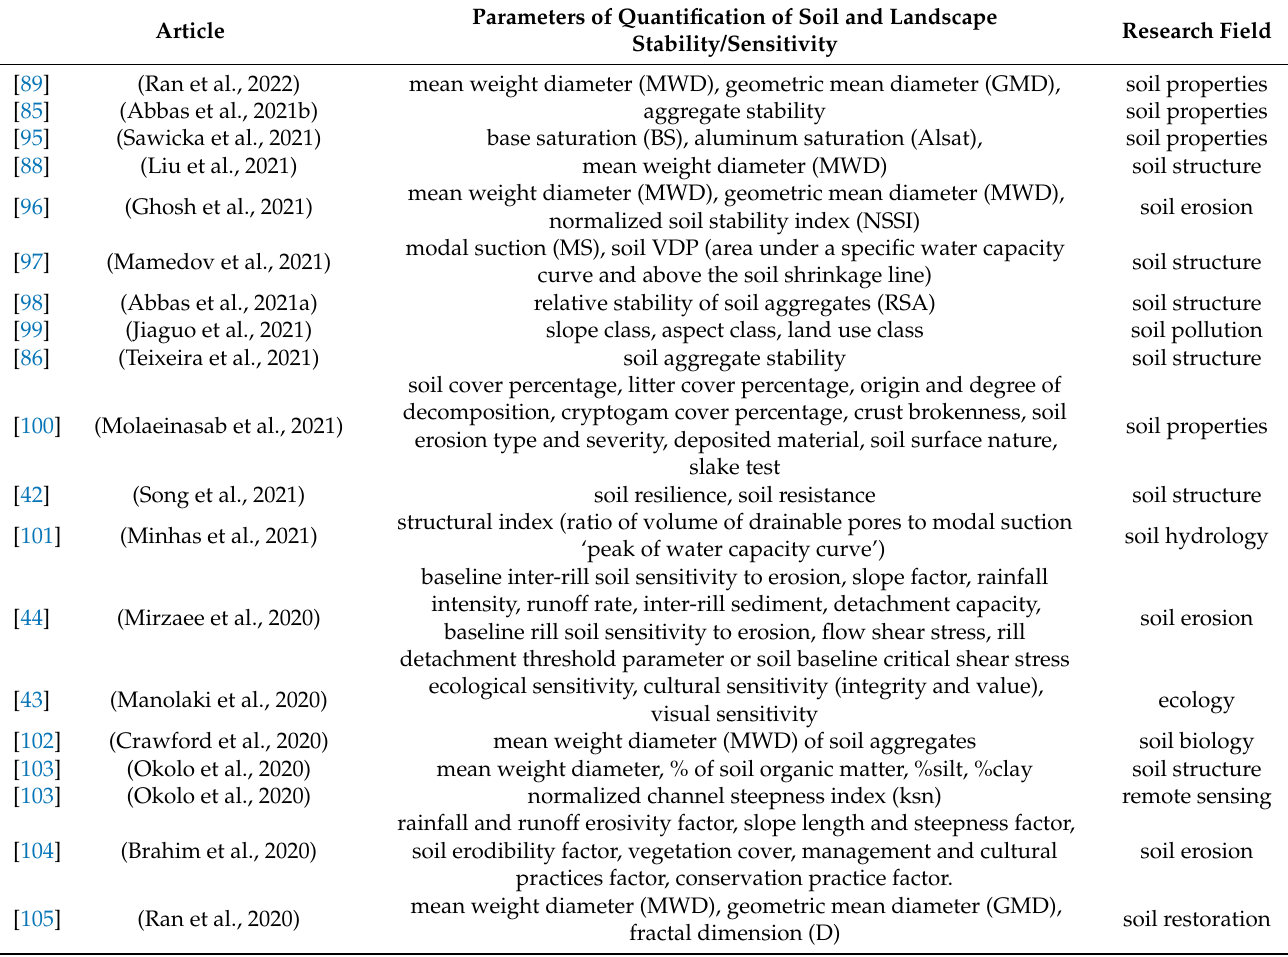
Table 7. Parameters of quantification of stability and